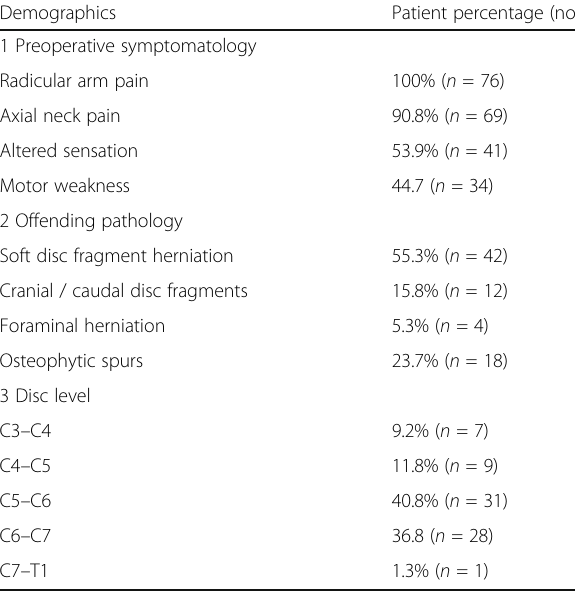
Table 1 Clinical symptoms attributable to different pathologies at disc levels Demographics Patient percentage